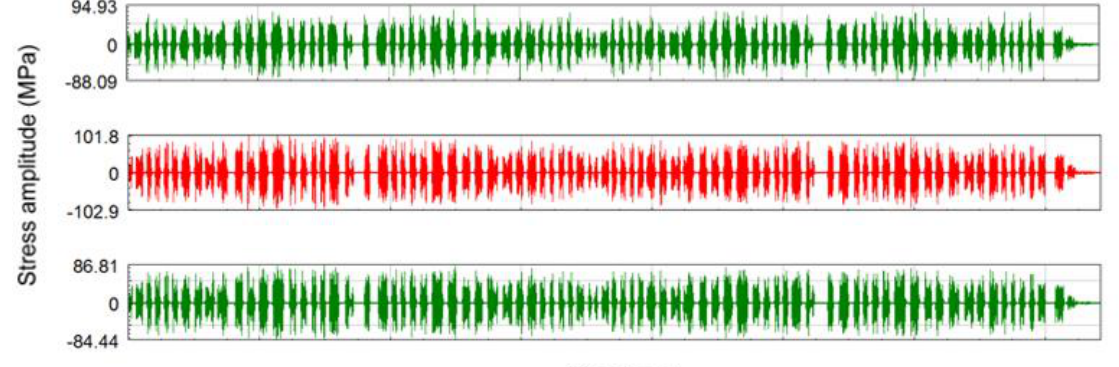
Figure 7. Full-range dynamic stress waveforms of D02, D11 and D17 (from top to bottom separately).